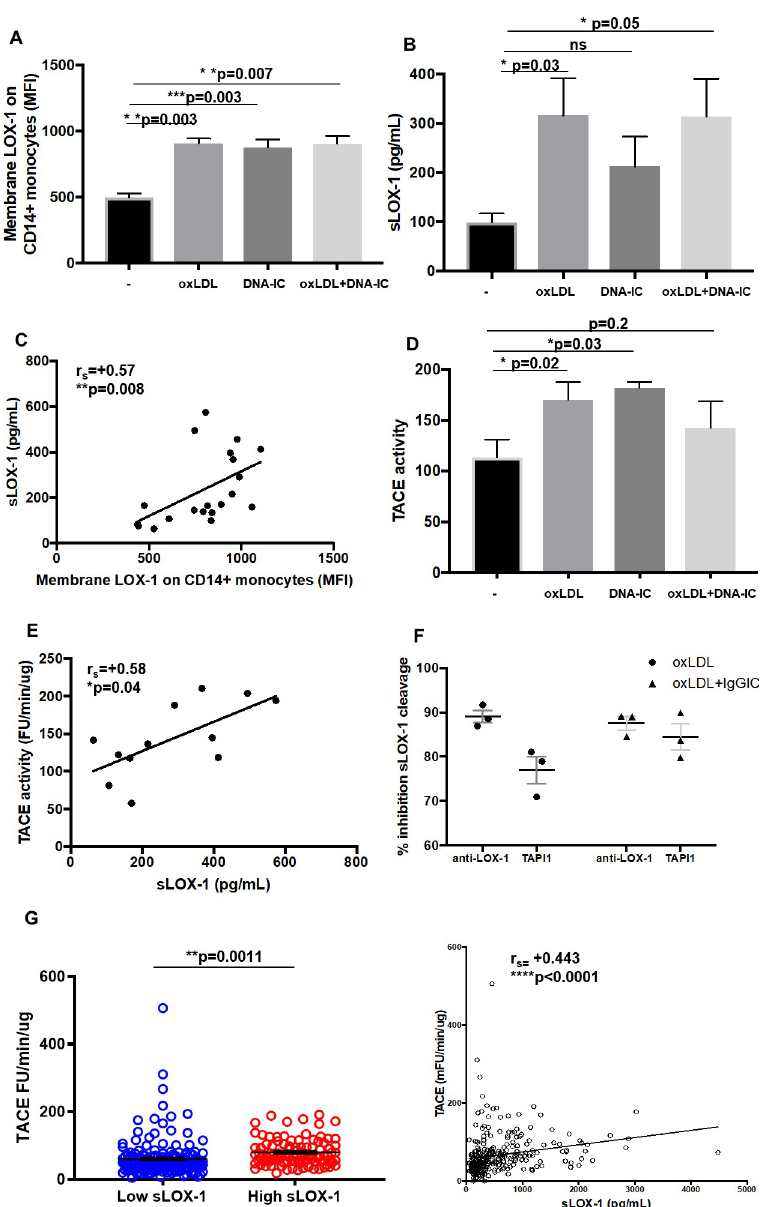
Fig 5. Relationship between induction of membrane LOX-1/sLOX-1 cleavage with TACE activity. Healthy monocytes were isolated from PBMCs and treated with oxLDL (30 μ g/mL) for 3h followed by DNA-IC (20 μ g/mL) (co)stimulation for 24h. (A) LOX-1 (MFI) expression on CD14+ monocytes. (B) sLOX-1 (pg/mL) detection from supernatant post 24h treatment. (C) Spearman correlation (r s ) between membrane LOX-1 (MFI) and sLOX-1 (pg/ mL). (D) Tumor necrosis factor alpha activating enzyme (TACE) activity (FU/min/ μ g) was measured using a fluorogenic peptide substrate (Mca-PLAQAV-Dpa-RSSSR-NH2) from supernatants post 24h treatment. (E) Spearman correlation (r s ) between sLOX-1 (pg/mL) and TACE activity (FU/min/ μ g). Data from in vitro experiments represented as mean ± SEM. (F) Inhibition of sLOX-1 cleavage in the presence of either the TAPI-1 inhibitor (100 μ M) or the LOX-1 receptor blocking antibody. (G) TACE activity measurements normalized to total protein in SLE patients with low (2.741 ± 0.3491, n = 168) and high (5.134 ± 0.7696, n = 100) sLOX-1. Relationship between TACE activity (FU/ min/ μ g) and sLOX-1 (pg/mL) from matched patient serum shown by Spearman correlation (r s ). Data represented as mean ± SEM. � p < 0.05, �� p < 0.01, ��� p < 0.001 and ���� p < 0.0001.